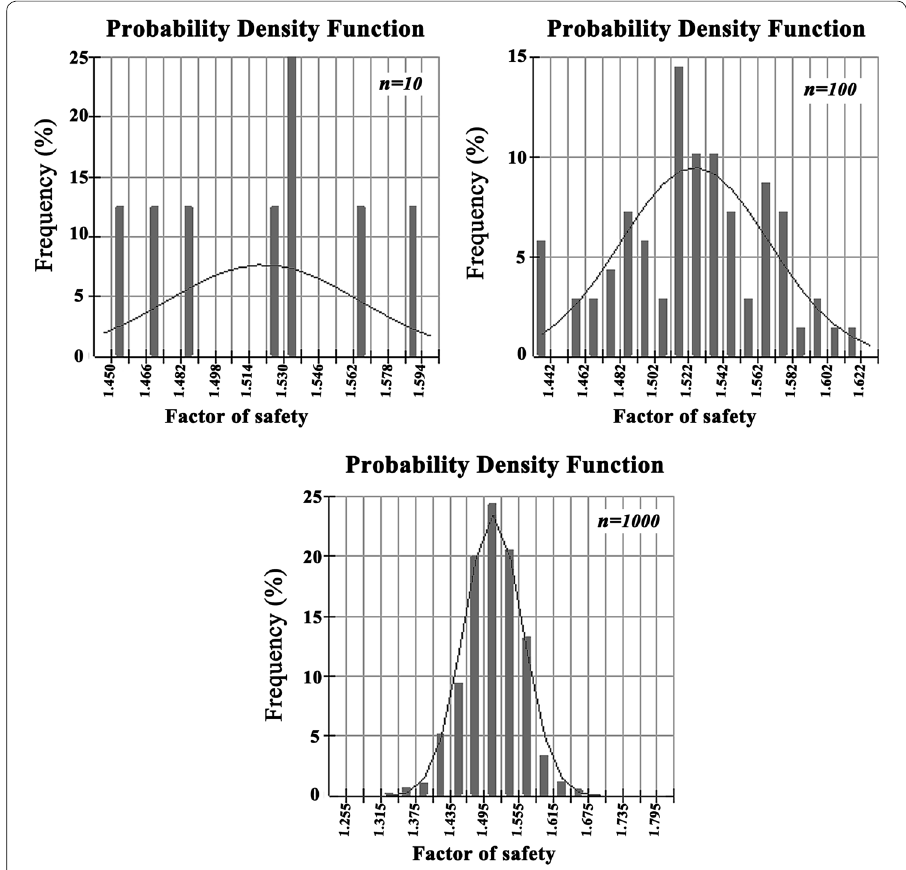
Fig. 11 Comparison of PDFs and histograms of safety factor in different numbers of